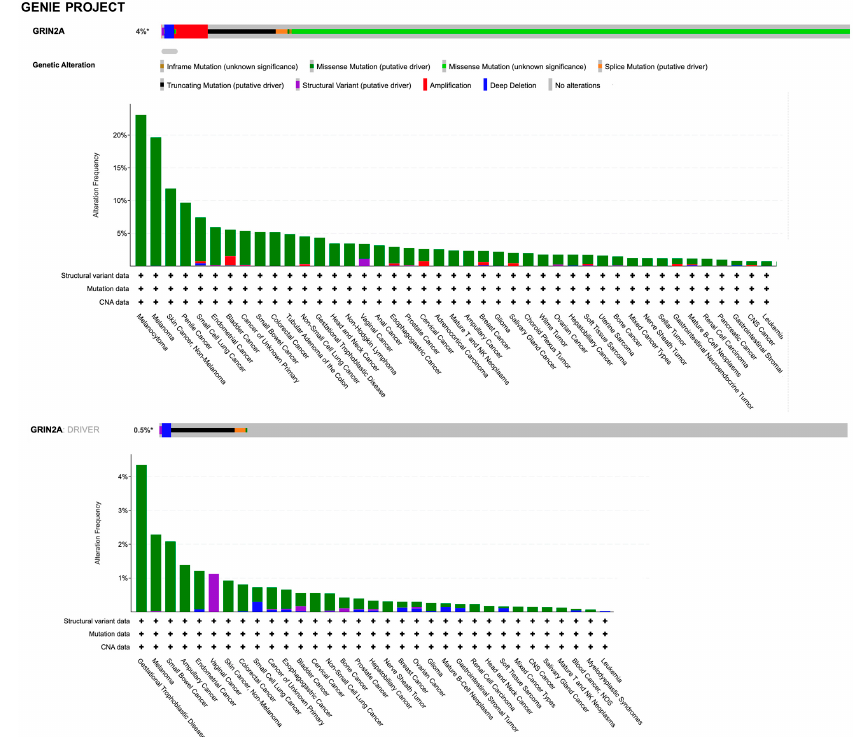
Figure 5. Summary graph of genomic alterations of GRIN2A gene and their distribution in cancer studies from AACR Project GENIE available in the cBioPortal. By querying the TCGA (The Cancer Genome Atlas Program) pan-cancer atlas studies, it was found that GRIN2A is altered in 5% of all cancers, with melanoma, lung, colorectal, bladder, and breast cancer having the greatest prevalence of alterations (Figure 6).